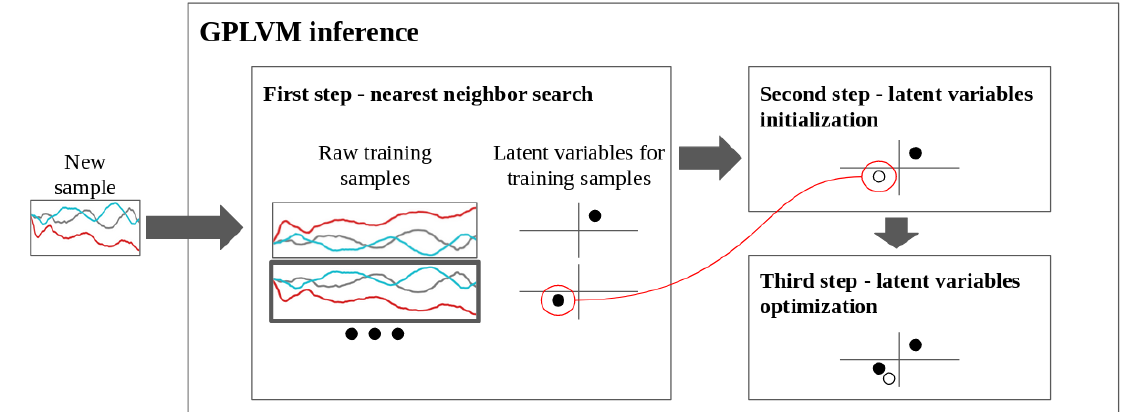
Figure 9. Global GPLVM inference process of the latent variables given a new sample in the higher dimensional space. First, the most similar training sample to the new sample is found using Euclidean distance. Second, the value of the latent variables of the most similar training sample (black dot in the first step) is used to initialize the inferred value (see the white dot in the second step). Third, the GPLVM model is optimized considering the new sample, which results in a refinement of the inferred latent variables. GPLVM with optimization includes the three steps; GPLVM without optimization stops after the